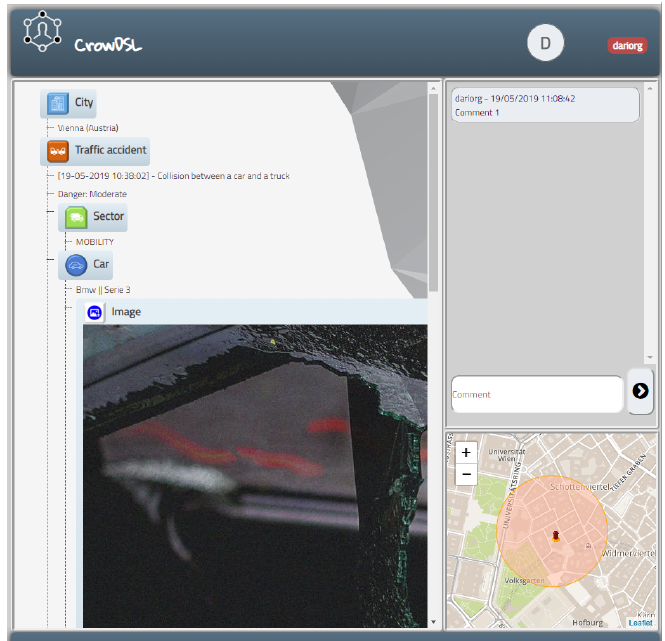
Figure 4. Visualization of an incident.